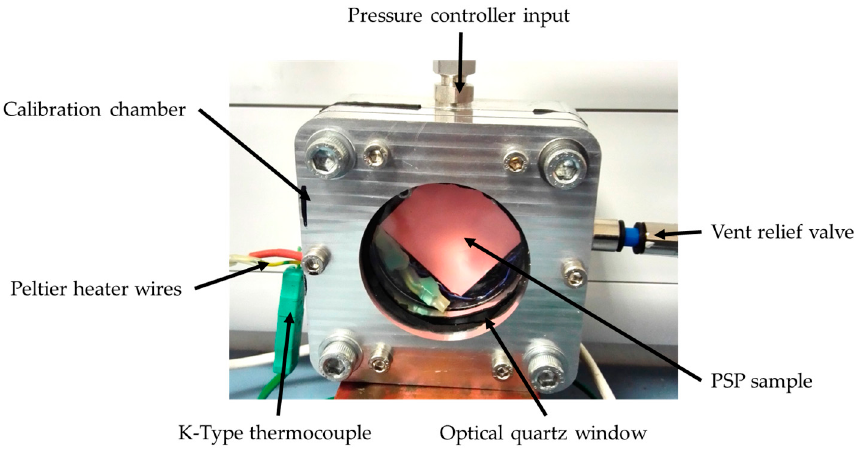
Figure 7. PSP calibration chamber.